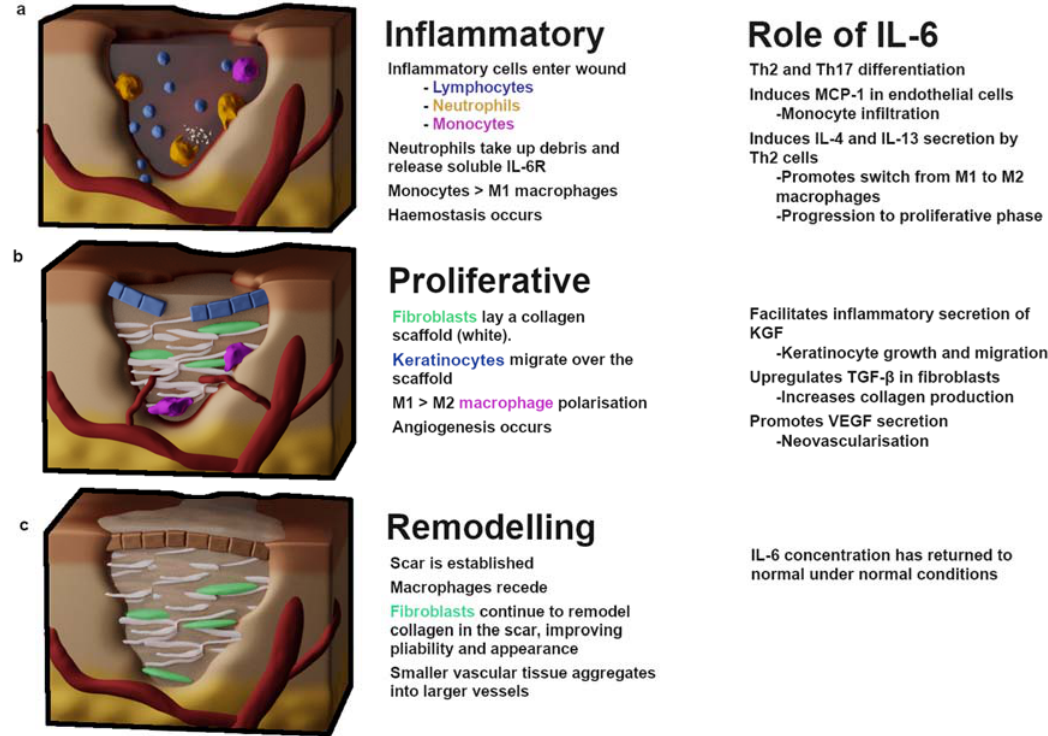
Figure 1. The stages of wound healing. a ) The inflammatory phase begins with the influx of platelets and clotting factors which induce hemostasis to prevent blood loss. Inflammatory leukocytes